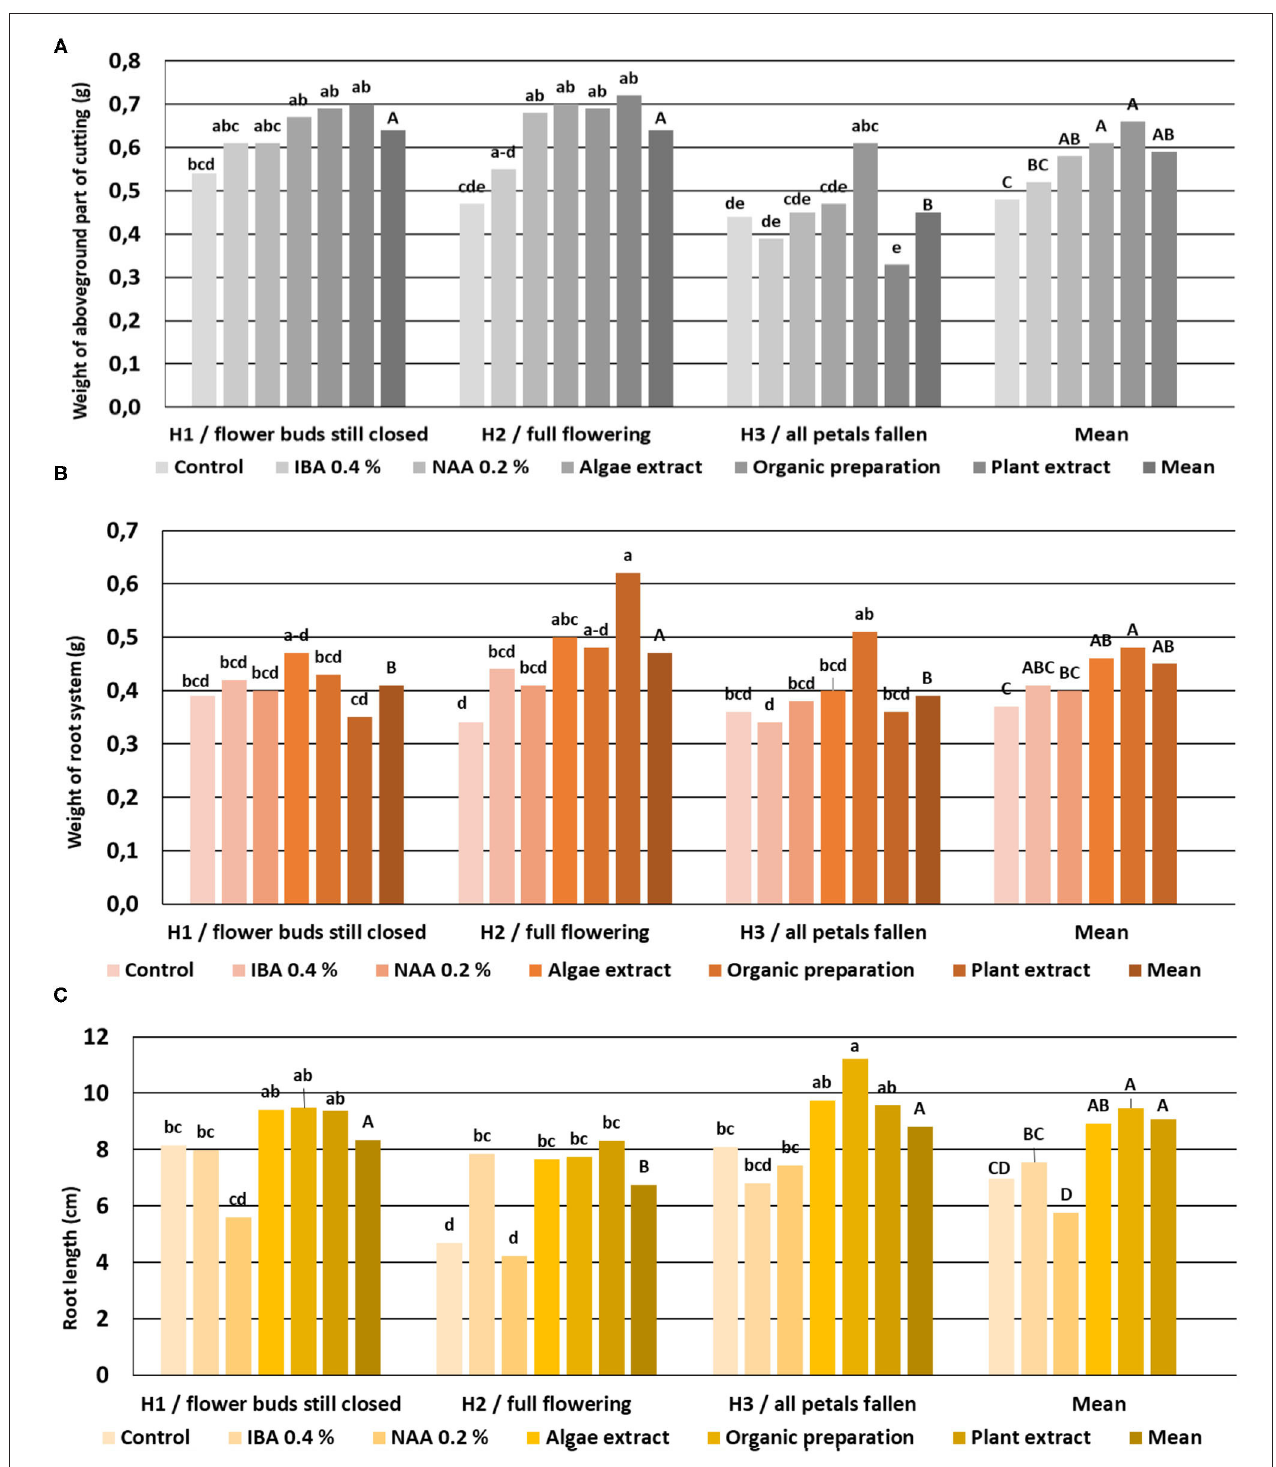
FIGURE 12 | The root length (C) , weight of the aboveground part (A) , and root system (B) in rooted cuttings of Rosa “Hurdal.” Control—the control cuttings; IBA, 0.4%—Ukorzeniacz A aqua (0.4% IBA); NAA, 0.2%—Ukorzeniacz B aqua (0.2% NAA); Algae extract—watering with 0.6% Bio Rhizotonic (10ml) after planting, 10 and 20 days later; Organic preparation—watering with 0.4% Root Juice TM (10ml) after planting; Plant extract—watering with 0.02% Bio Roots (10ml) after planting. H1 − 54 504 (flower buds still closed); H2 − 69 605 (full flowering; at least 50% of flowers open); H3 − 69 629 (end of flowering of the second-order stem—all petals have fallen); H4 − 70 701 [fruit set: beginning of hip (berry) growth on the main stem]. Different small letters indicate significant interactions between the phenological stage and treatment (two-way ANOVA). Different capital letters indicate significant differences between phenological stages. Tukey’s test ( α = 0.05) was used.